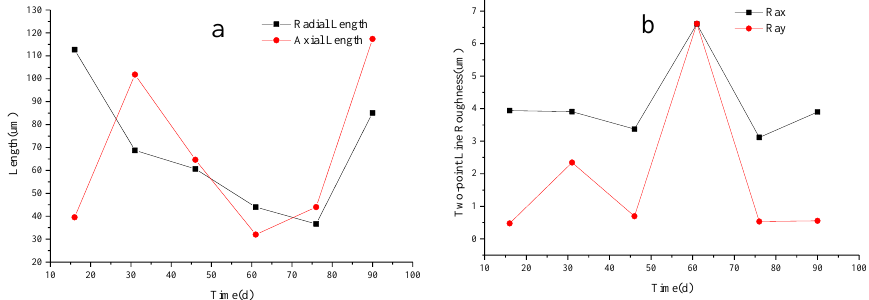
Figure 15. Micro-structure of the wheat stalk over time with dry rotary tillage. Note: ( a ) Changing of radial and axial length over time with dry rotary tillage, ( b ) Changing of R ax and R ay over time with dry rotary tillage.